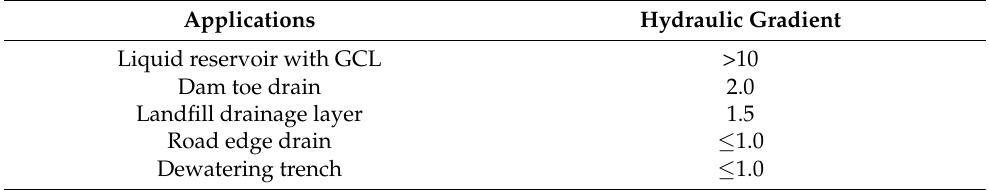
Table 6. Typical values of the hydraulic gradient in soil next to the geotextile filter (adapted from [85]). Applications Hydraulic Gradient Liquid reservoir with GCL >10 Dam toe drain 2.0 Landfill drainage layer 1.5 Road edge drain Dewatering